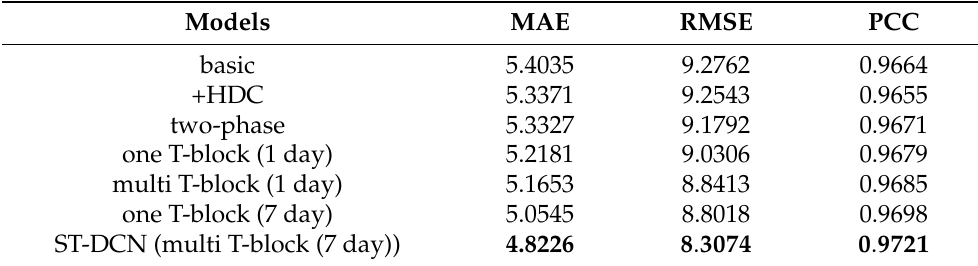
Table 3. Evaluation of different variants on the NYC taxi